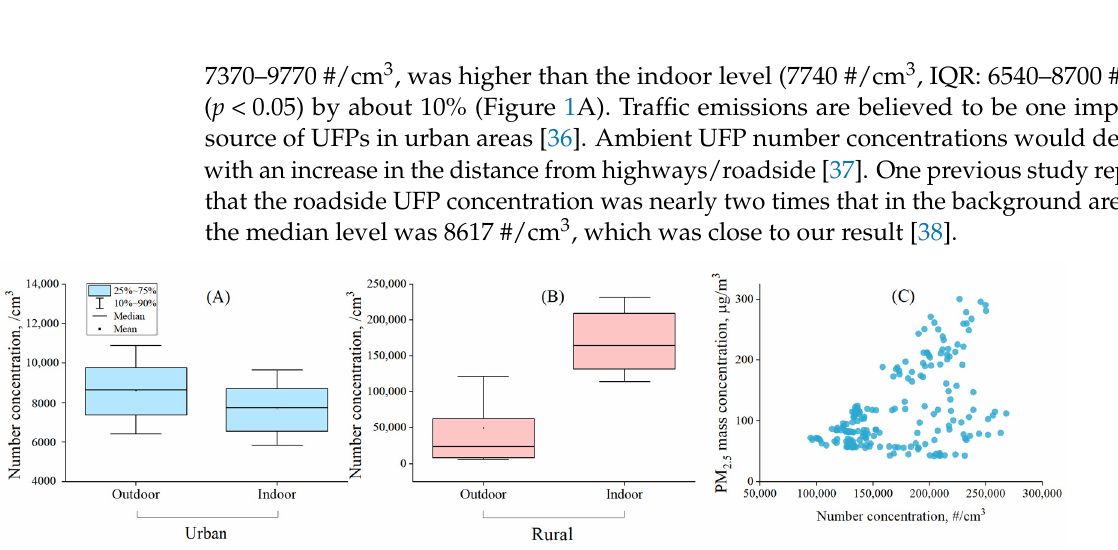
Figure 1. Indoor and outdoor UFP number concentrations in the urban room without internal combustion sources ( A ), the rural household with coal combustion indoors ( B ), and the relationship between indoor UFP number concentration and PM 2.5 mass concentration in the rural household burning coal ( C ).